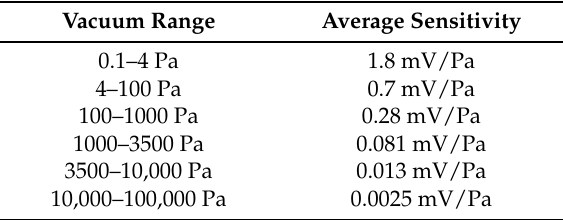
Table 1. The sensitivity of the Pirani sensor in different vacuum ranges.